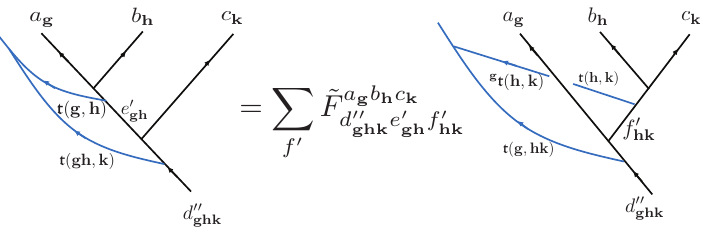
Figure 6: Diagram depicting F symbols of the new theory, which we de- note as ˜ F , in terms of labeling of objects in the original